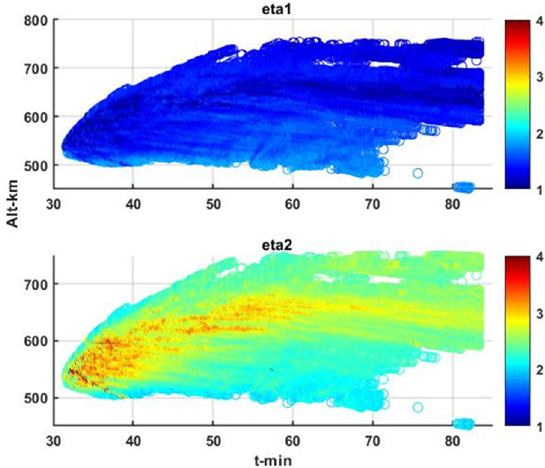
Fig. 3 Altitude-dependent EPB index-parameter ( η 1 upper frame, η 2 lower frame) evolution